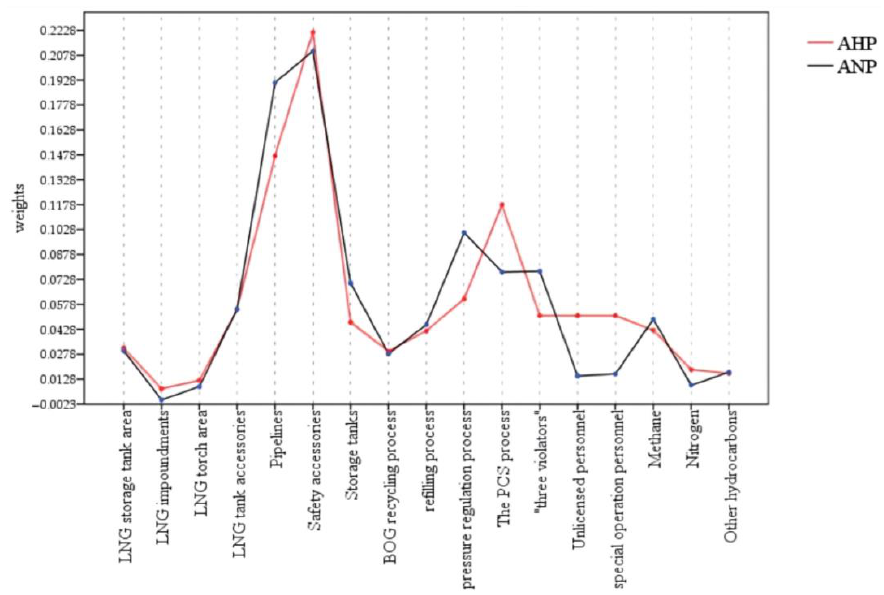
Figure 8. Secondary index weights in AHP.